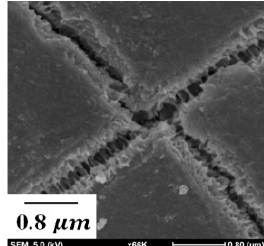
Figure 8. Magnified SEM image showing cracks in chromium-conversion-treated Zn–Ni flakes.